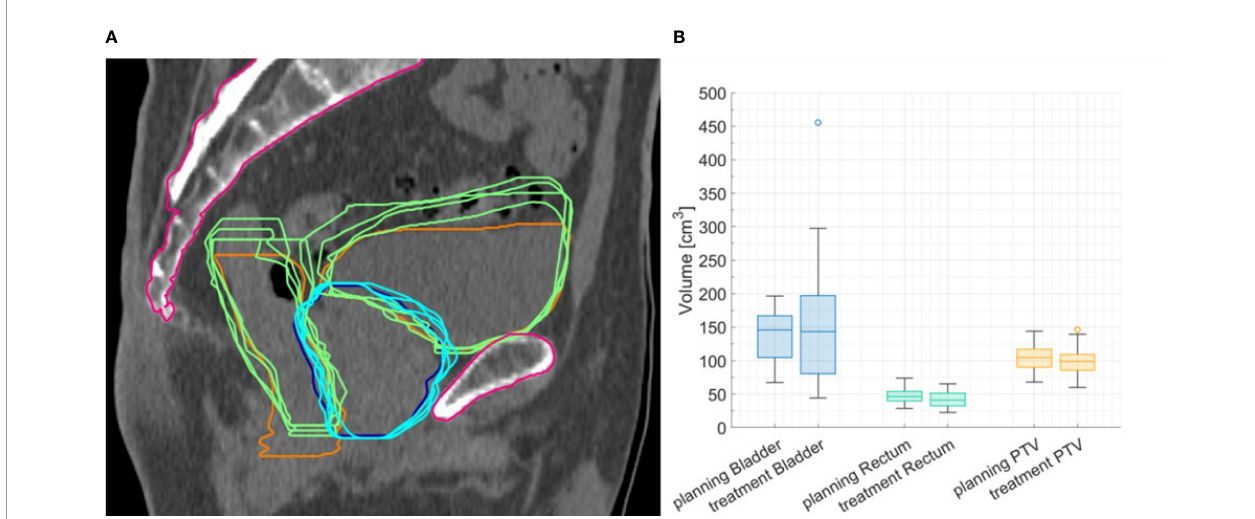
FIGURE 2 | (A) Representative planning image with planning computed tomography (CT) contours of planning target volume (PTV) (blue line) and rectum and bladder (orange lines), with contours delineated on cone beam CTs (CBCTs) superimposed (light-blue and green lines). (B) Boxplots for bladder, rectum, and PTV volume at planning CT and CBCT for the whole cohort.